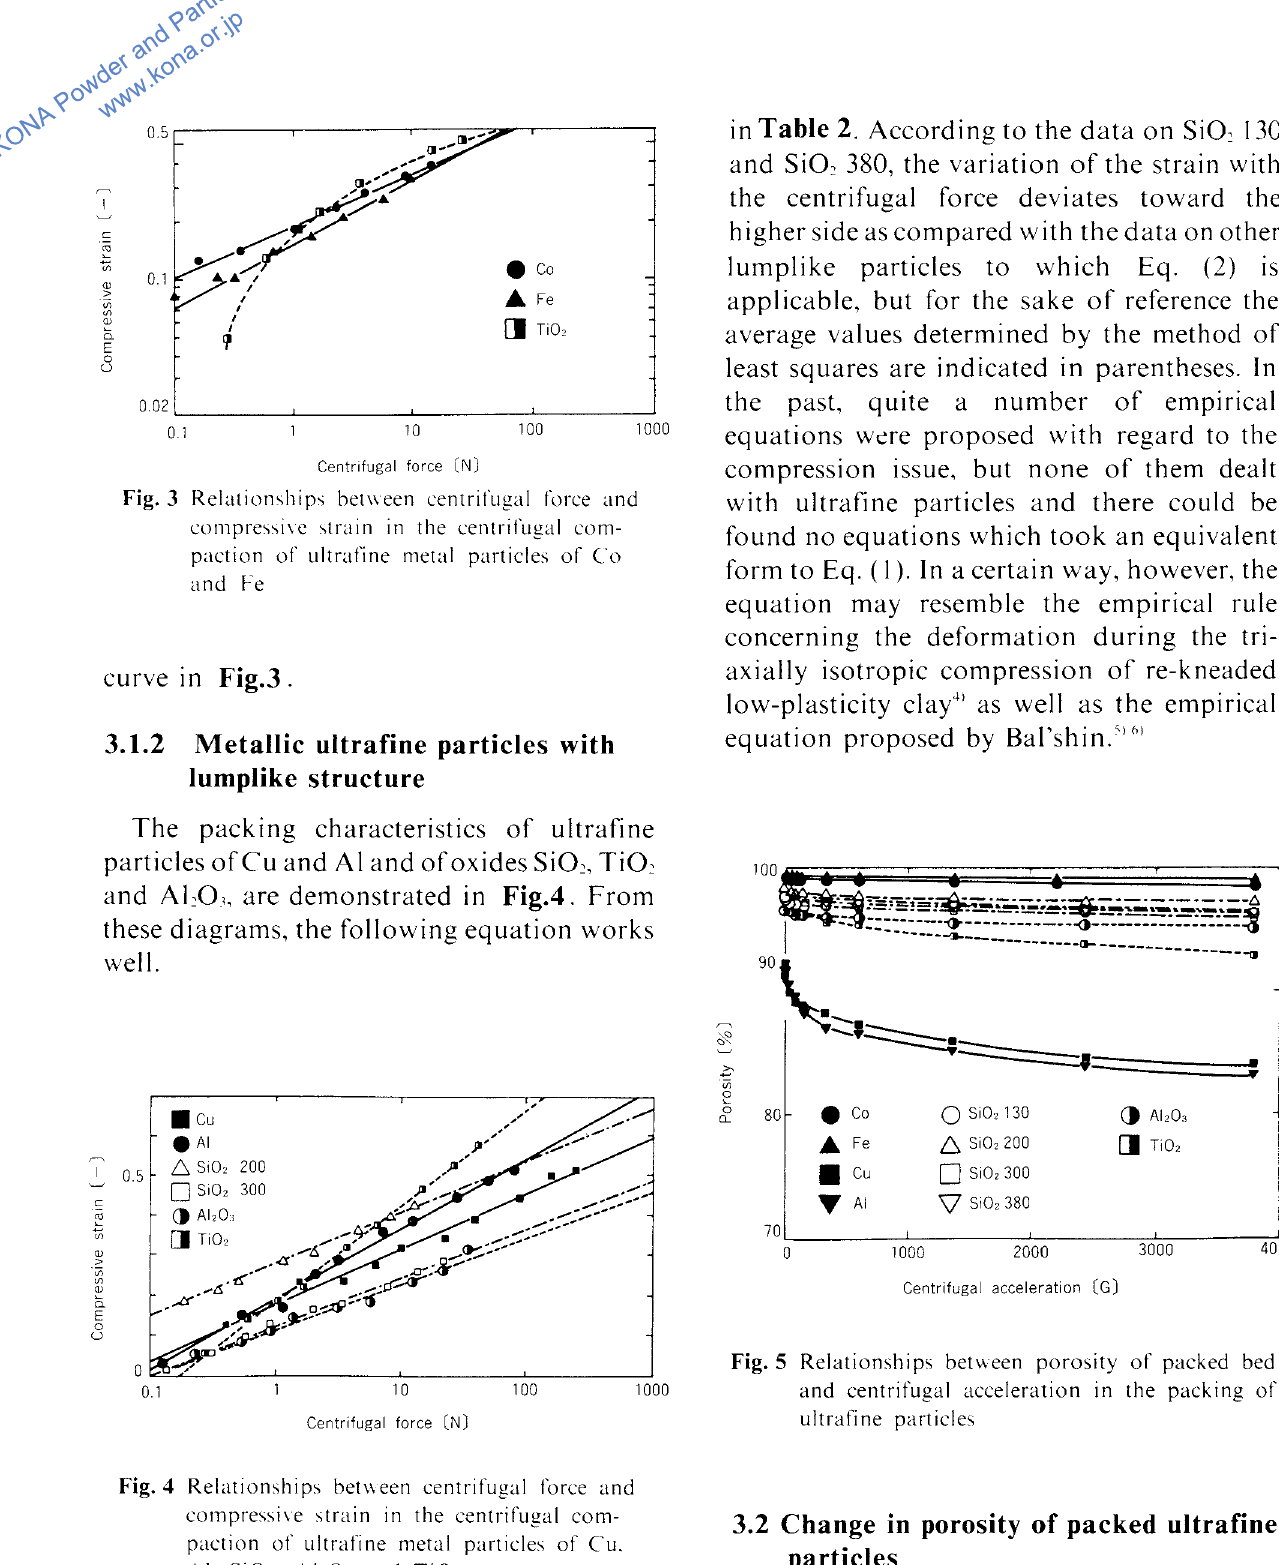
Fig. 5 Relationships between porosity of packed